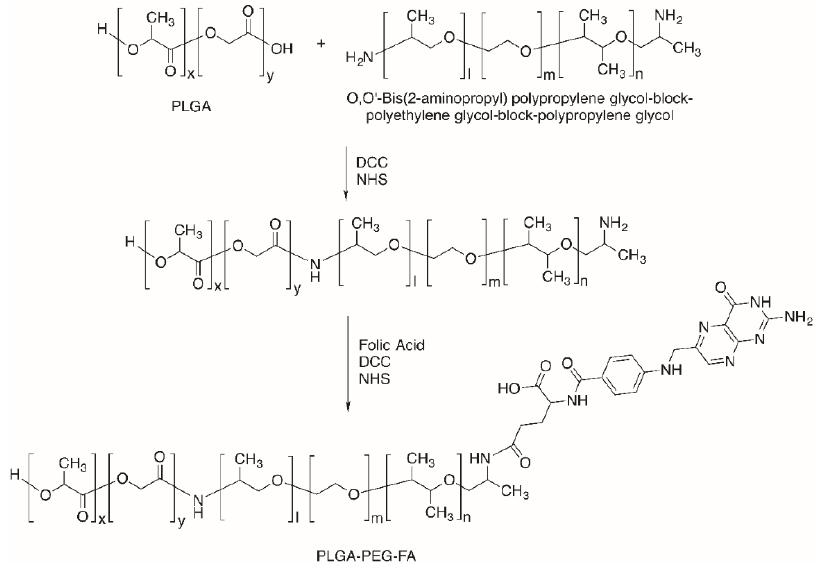
Figure 1. Schematic of the synthesis of the polymer poly ‐ DL ‐ lactic ‐ co ‐ glycolic (PLGA) polyethylene glycol (PEG) folic acid (PLGA ‐ PEG ‐ FA). First, PLGA carboxylic acid is activated and coupled to a primary amine of PEG (PLGA ‐ PEG). Then, a carboxylic acid from FA is activated and conjugated to the primary amine of PLGA ‐ PEG to finally obtain PLGA ‐ PEG ‐ FA.